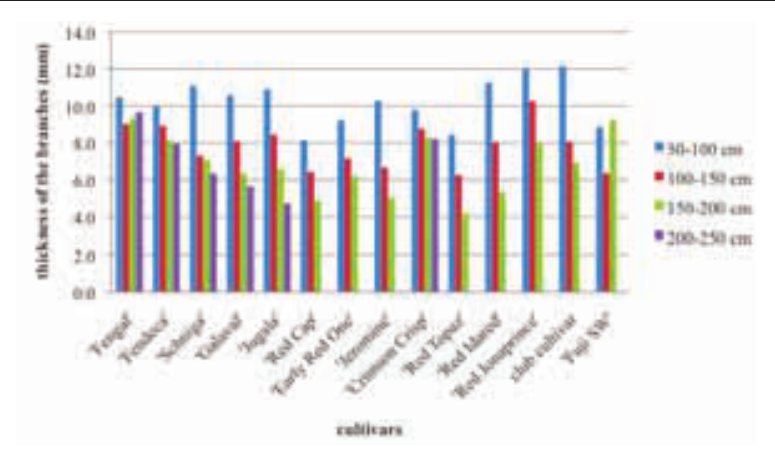
Figure 3: Average thickness of the branches of the central leader in different height zones (mm) (Nyírbátor, 2013)